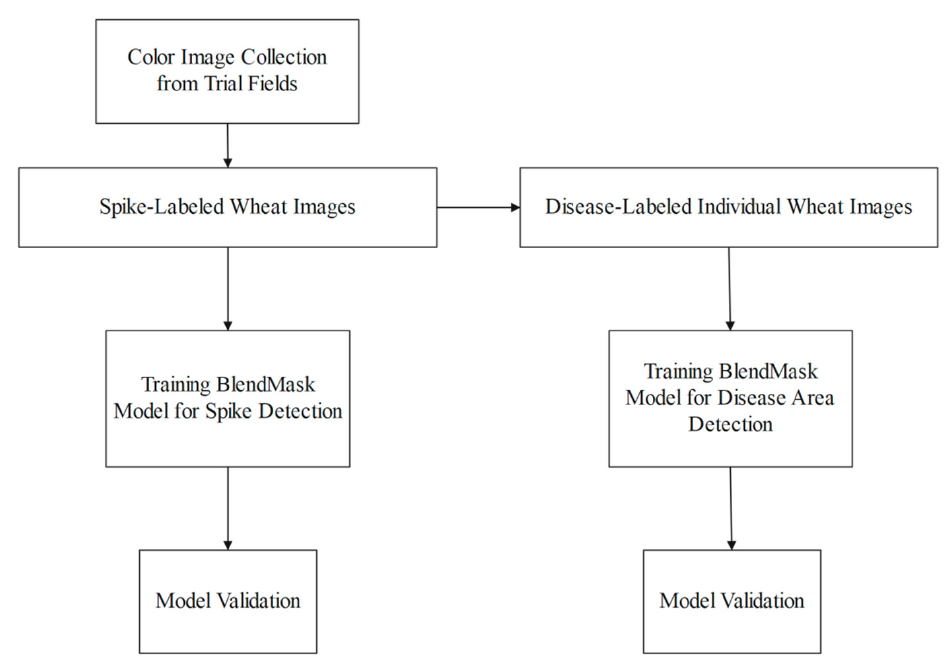
Figure 2. The architecture of the BlendMask approach for wheat Fusarium head blight (FHB) disease detection.